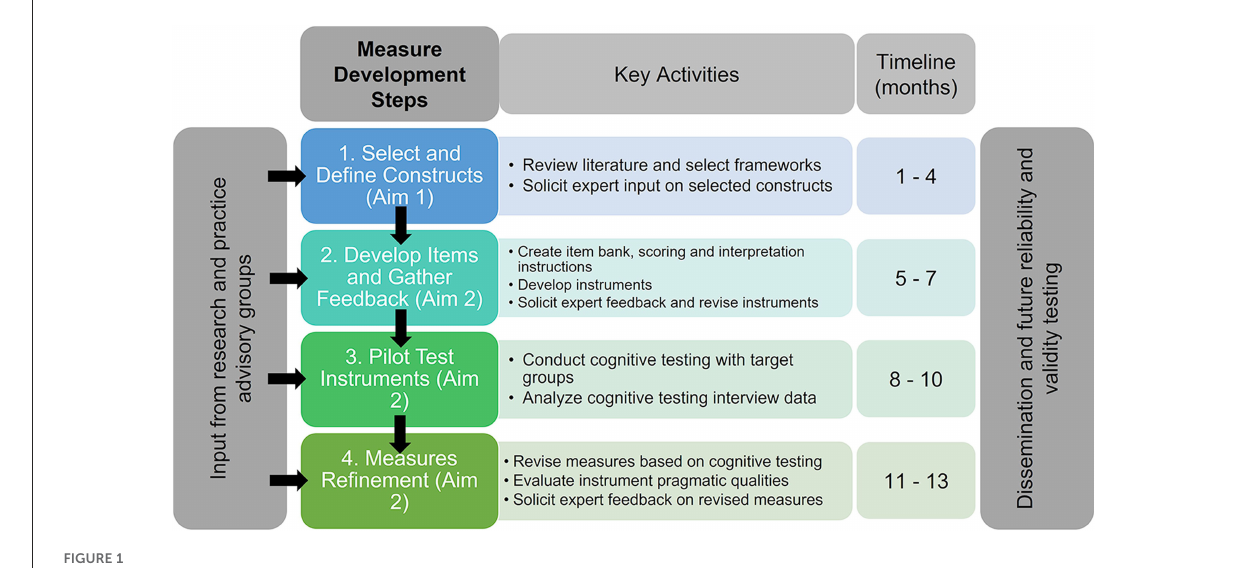
FIGURE1 Overview of measure development study